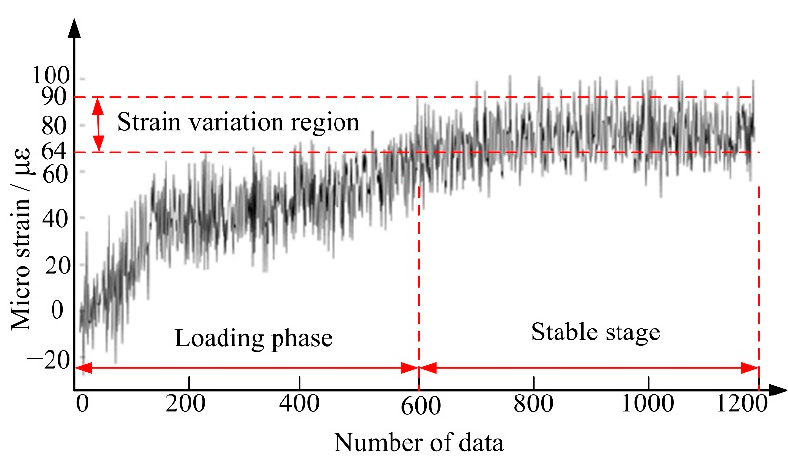
Figure 14. Strain curve of rolling element exiting variable diameter raceway.